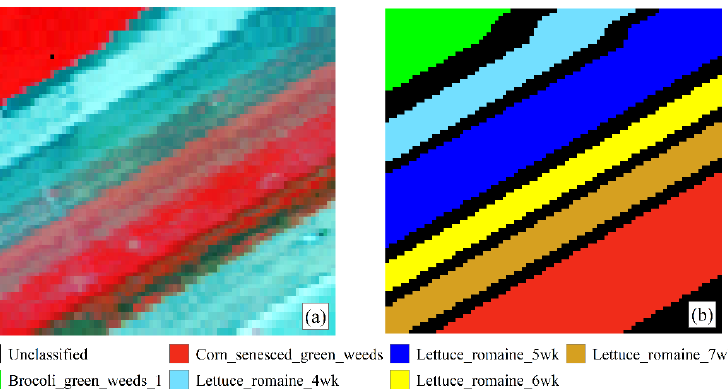
Figure 2. ( a ) The SA dataset; and ( b ) ground truth for the same area of the Salinas Valley. Table 1. The number of samples for the PU and SA dataset. Dataset Class No. Land Cover/Use Type